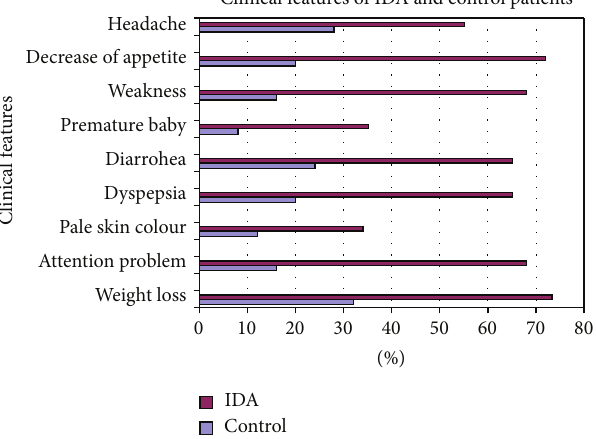
Figure 19: Showing clinical features of IDA and control patients.